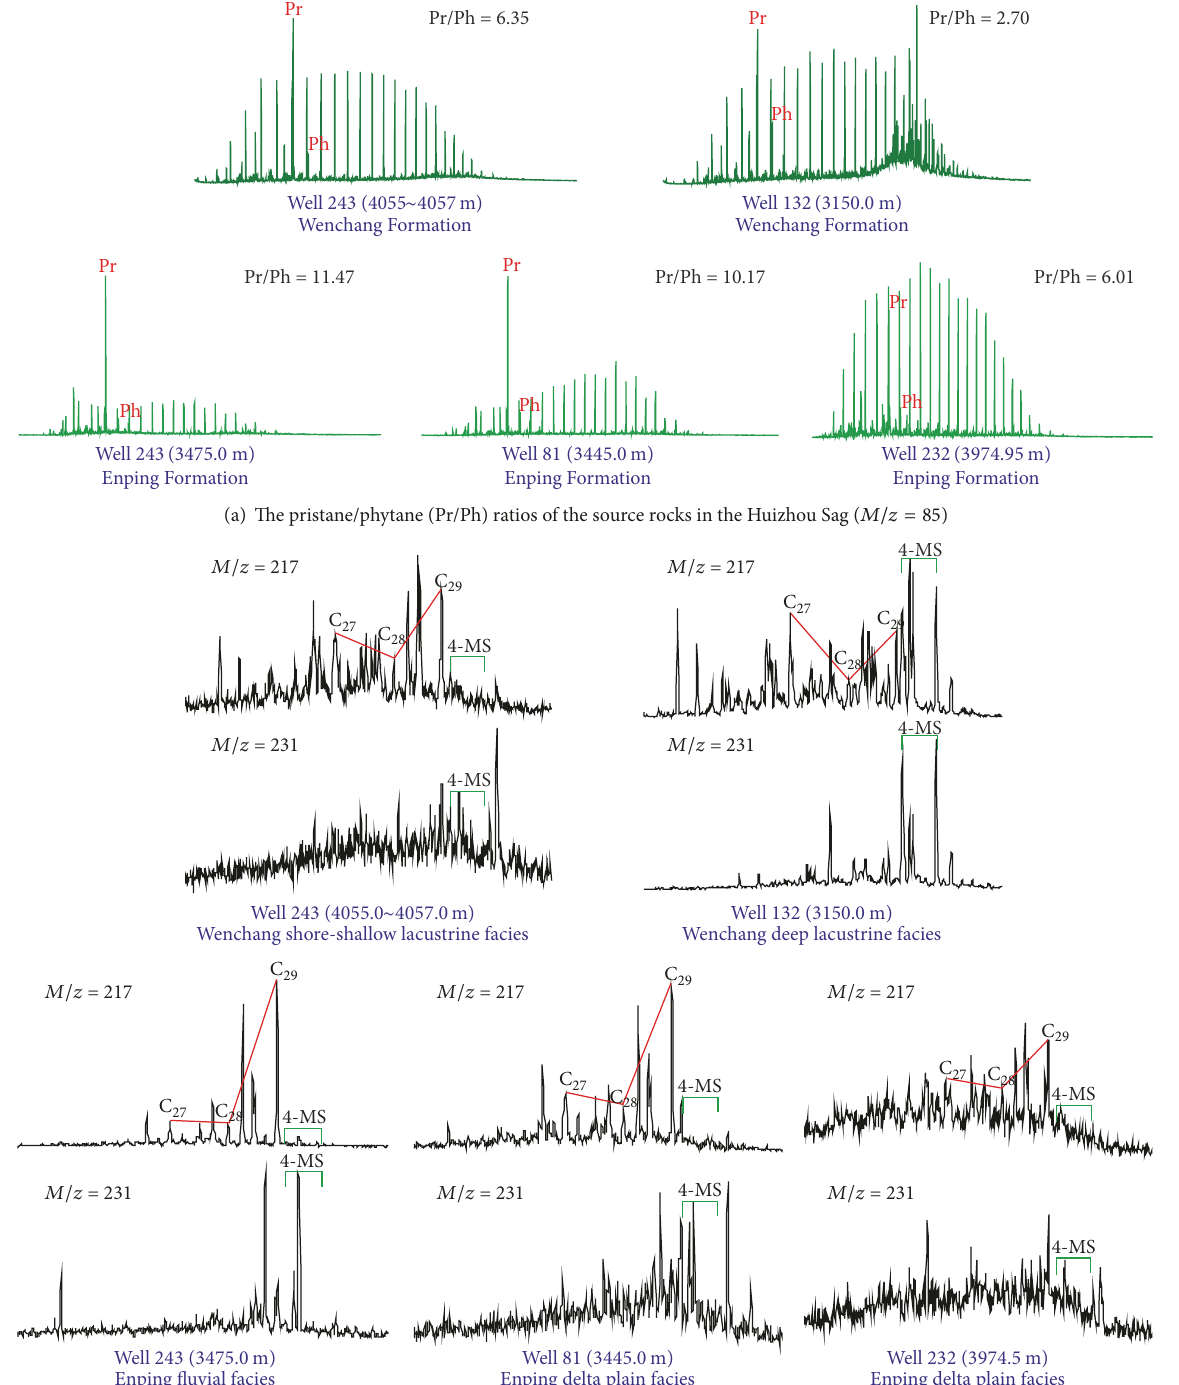
Figure 10: Representative gas chromatography and partial mass chromatograms of saturates in the Huizhou Sag (HZS) [45].